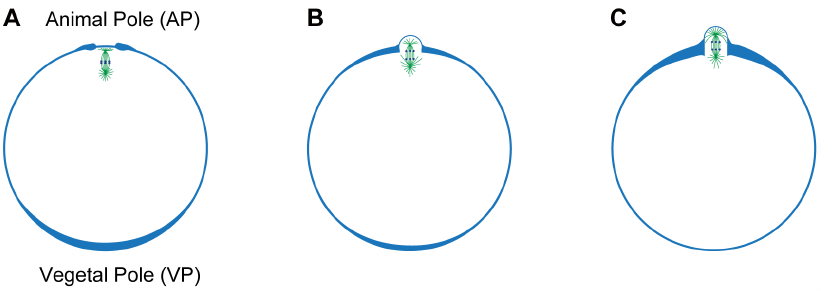
Figure 8. Force generation mechanism to ensure precise chromosome segregation for normal meiotic cell division. The magnitude of the tension is indicated by varying the thickness of the blue line. The meiotic apparatus is shown by the green line. Chromosomes are shown by the filled blue circles. (A) Before bulging started, the global tension around the animal pole is smaller than that in the vegetal pole. The meiotic apparatus exists just under the cell membrane at the animal pole. (B) After the onset of the bulge formation, the global tension around the animal pole starts to increase. Locally, the surface at the top of the animal pole weakens to form a bulge of the polar body; in contrast, the tension at the base of the bulge increases. The dividing furrow is formed in the equatorial plane of the meiotic apparatus. (C) As the bulge grows, the tension additionally increases at the base of the bulge. The meiotic apparatus moves into the bulge and is kept under the membrane. The position of the dividing furrow is in the equatorial plane of the mitotic apparatus.